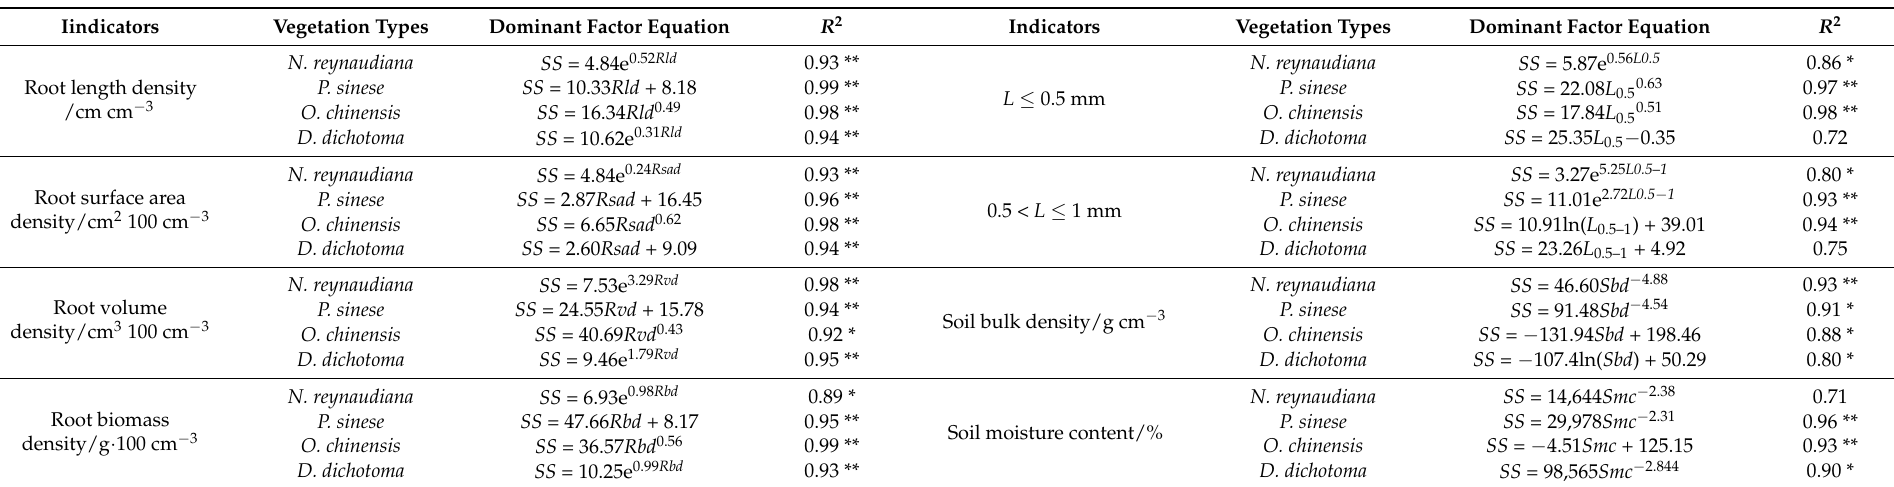
Table 9. Fitting equations of the shear strength of the root–soil complex ( SS ) and root